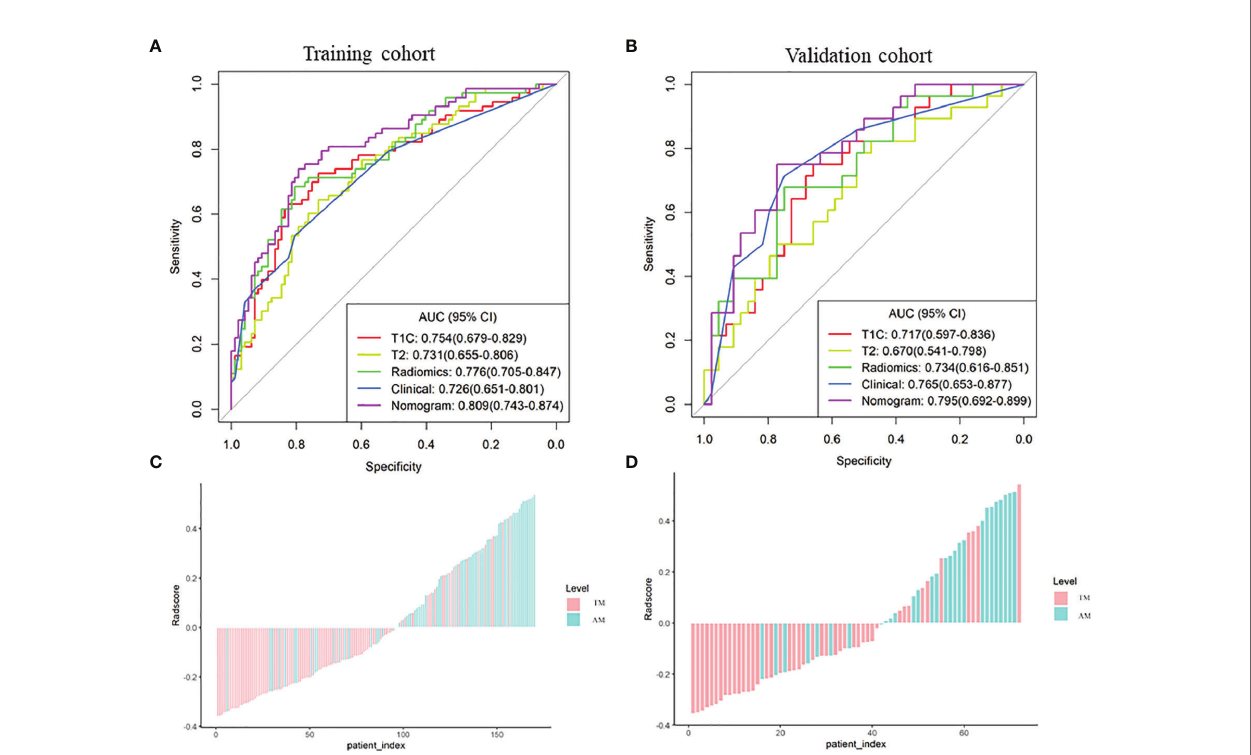
FIGURE 5 | Comparison of the receiver operating characteristic (ROC) curves of the different models. (A, B) ROC curves of the different models in the training and validation cohorts. The clinicoradiomic model demonstrates the best discrimination ability among these models, with area under the curve (AUC) values of 0.809 and 0.795 in the training and validation cohorts, respectively. (C, D) Radiomic signature histogram of the training and validation cohorts. The red bar shows the sample with transitional meningioma (TM), and the blue bar shows the sample with atypical meningioma